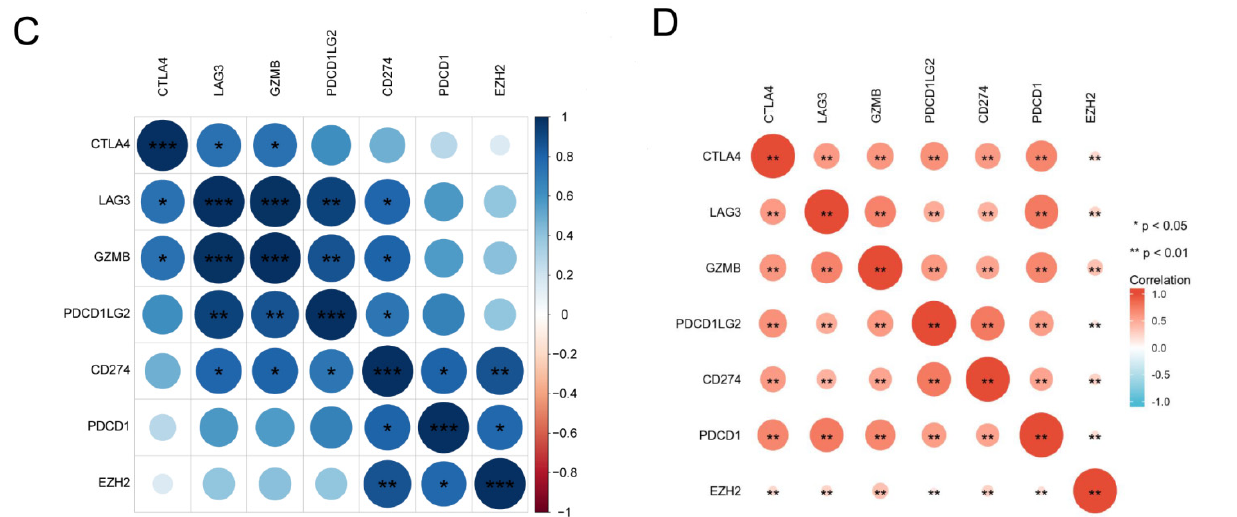
Figure 3. Characterization of the shared gene EZH2 in immune cells. Comparison of immune cell subsets with high EZH2 expression and low EZH2 expression in sepsis patients’ PBMCs ( A ) and NSCLC patients’ lung tissues ( B ). Spearman correlation analysis of EZH2 and T cell exhaustion- related molecules in sepsis ( C ) and NSCLC ( D ). Markers include CD274 , PDCD1 , CTLA4 , LAG3 , GZMB , and PDCD1LG2 of T cell exhaustion. * p < 0.05, ** p < 0.01, *** p < 0.005, **** p < 0.001, ns: no significance.